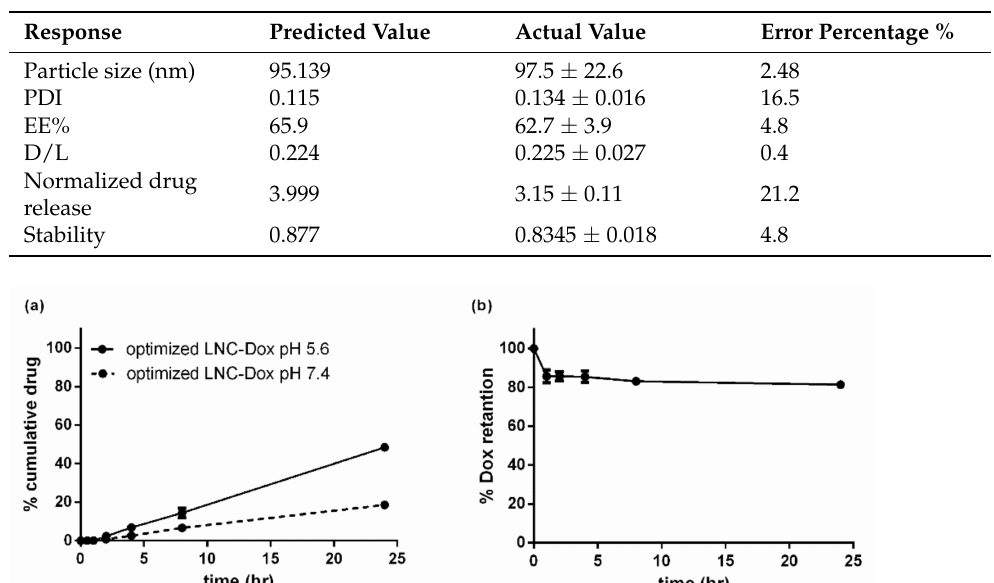
Table 4. Predicted and actual values of the optimized LNC-Dox. Values are expressed as the mean ± SD ( n = 3).